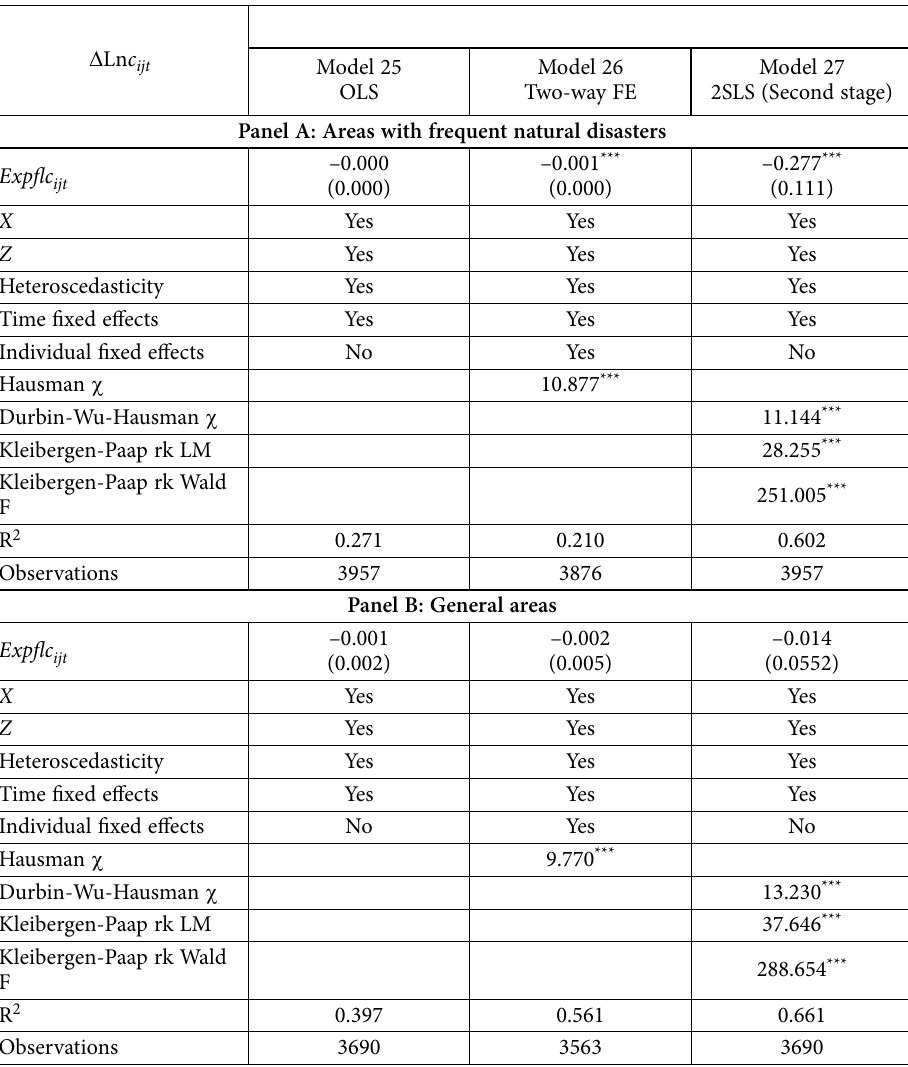
Table 11. The estimation results of group regression of disaster